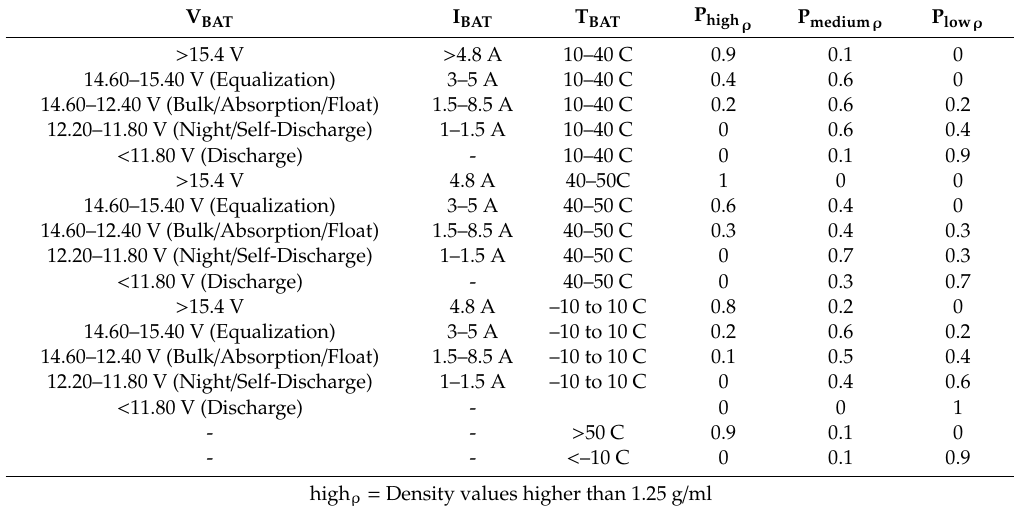
Table 4. Probabilities and possible states for electrolyte density.